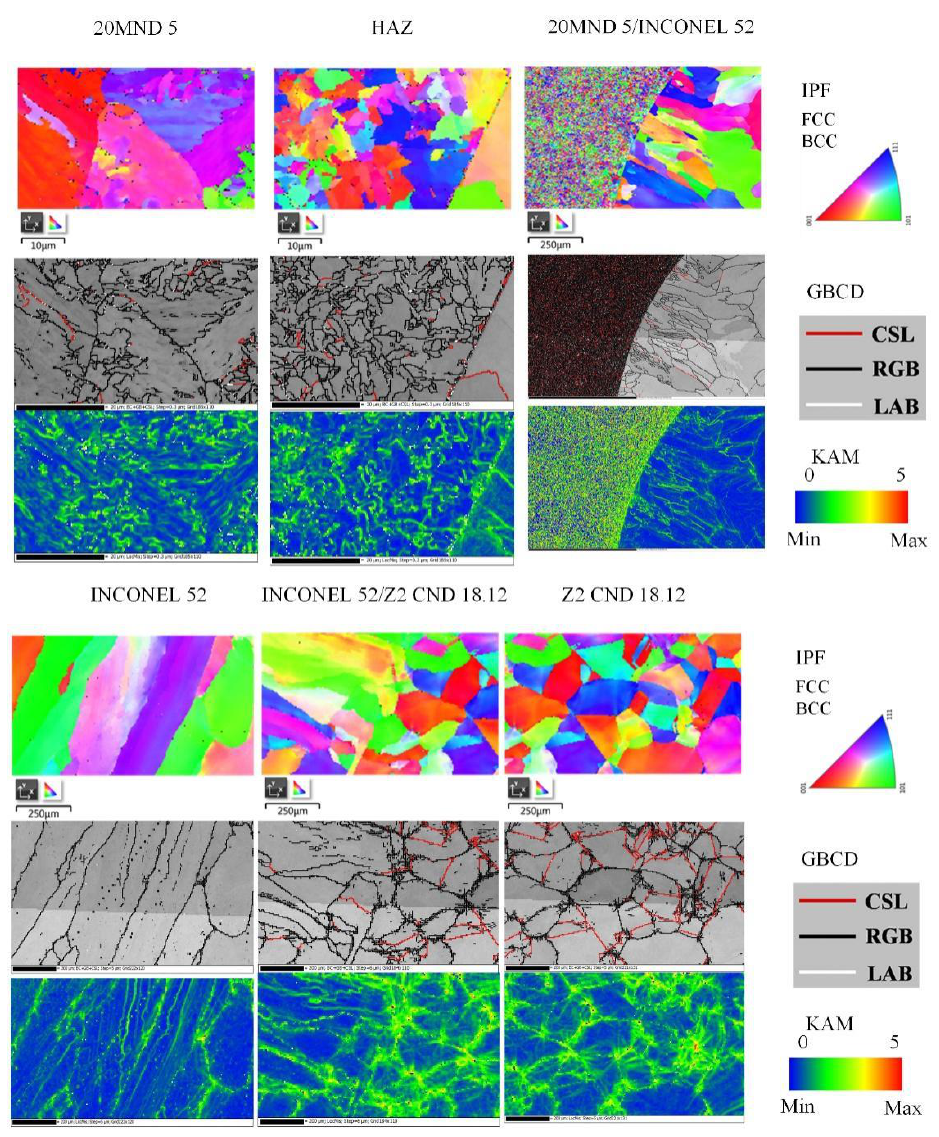
Figure 13. EBSD analyses of different regions of the DMW joint. Table 2. Uniaxial tensile testing results of BMs and a DMW